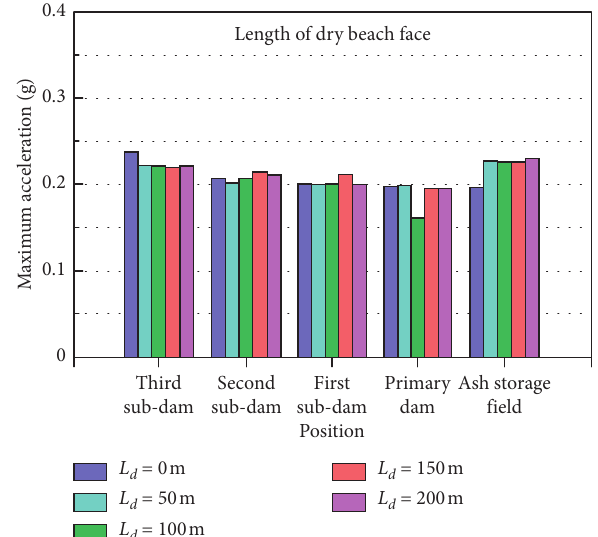
Figure 7: Peak acceleration of various parts of ash storage field at different dry beach lengths.